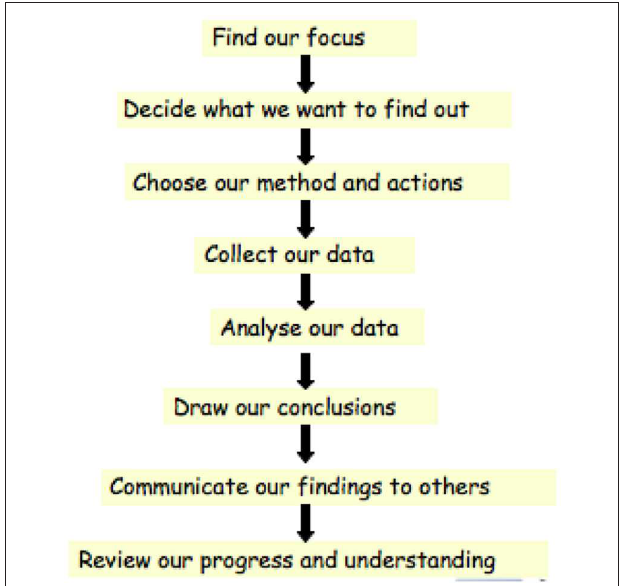
FIGURE 1 | An Inquiry learning framework presented as a linear model.